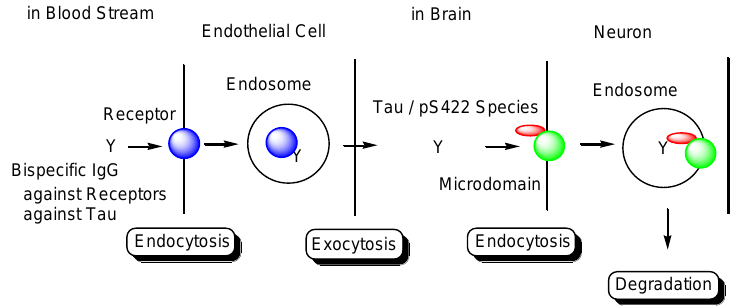
Figure 14. Tau/pS422 species lysosomal degradation through membrane microdomain-mediated endocytosis in neurons using bispecific Abs against tau/pS422 and receptors.